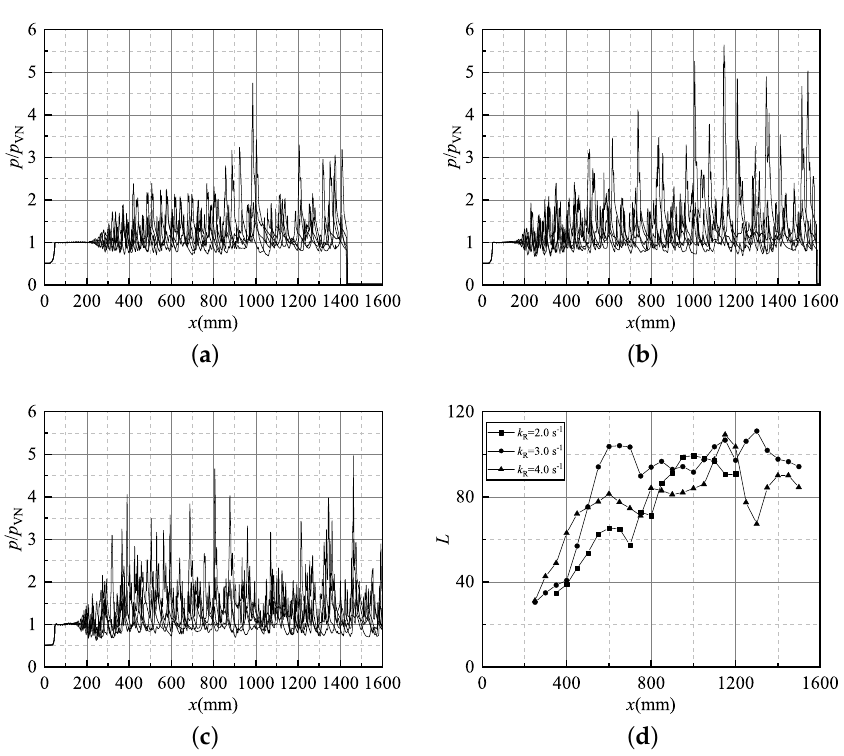
Figure 6. Pressure history and cell length variation for three cases without artificial perturbations, ( a ) k R = 2 s − 1 , ( b ) k R = 3 s − 1 , ( c ) k R = 4 s − 1 , and ( d ) cell